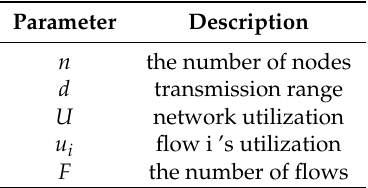
Table 1. Simulation